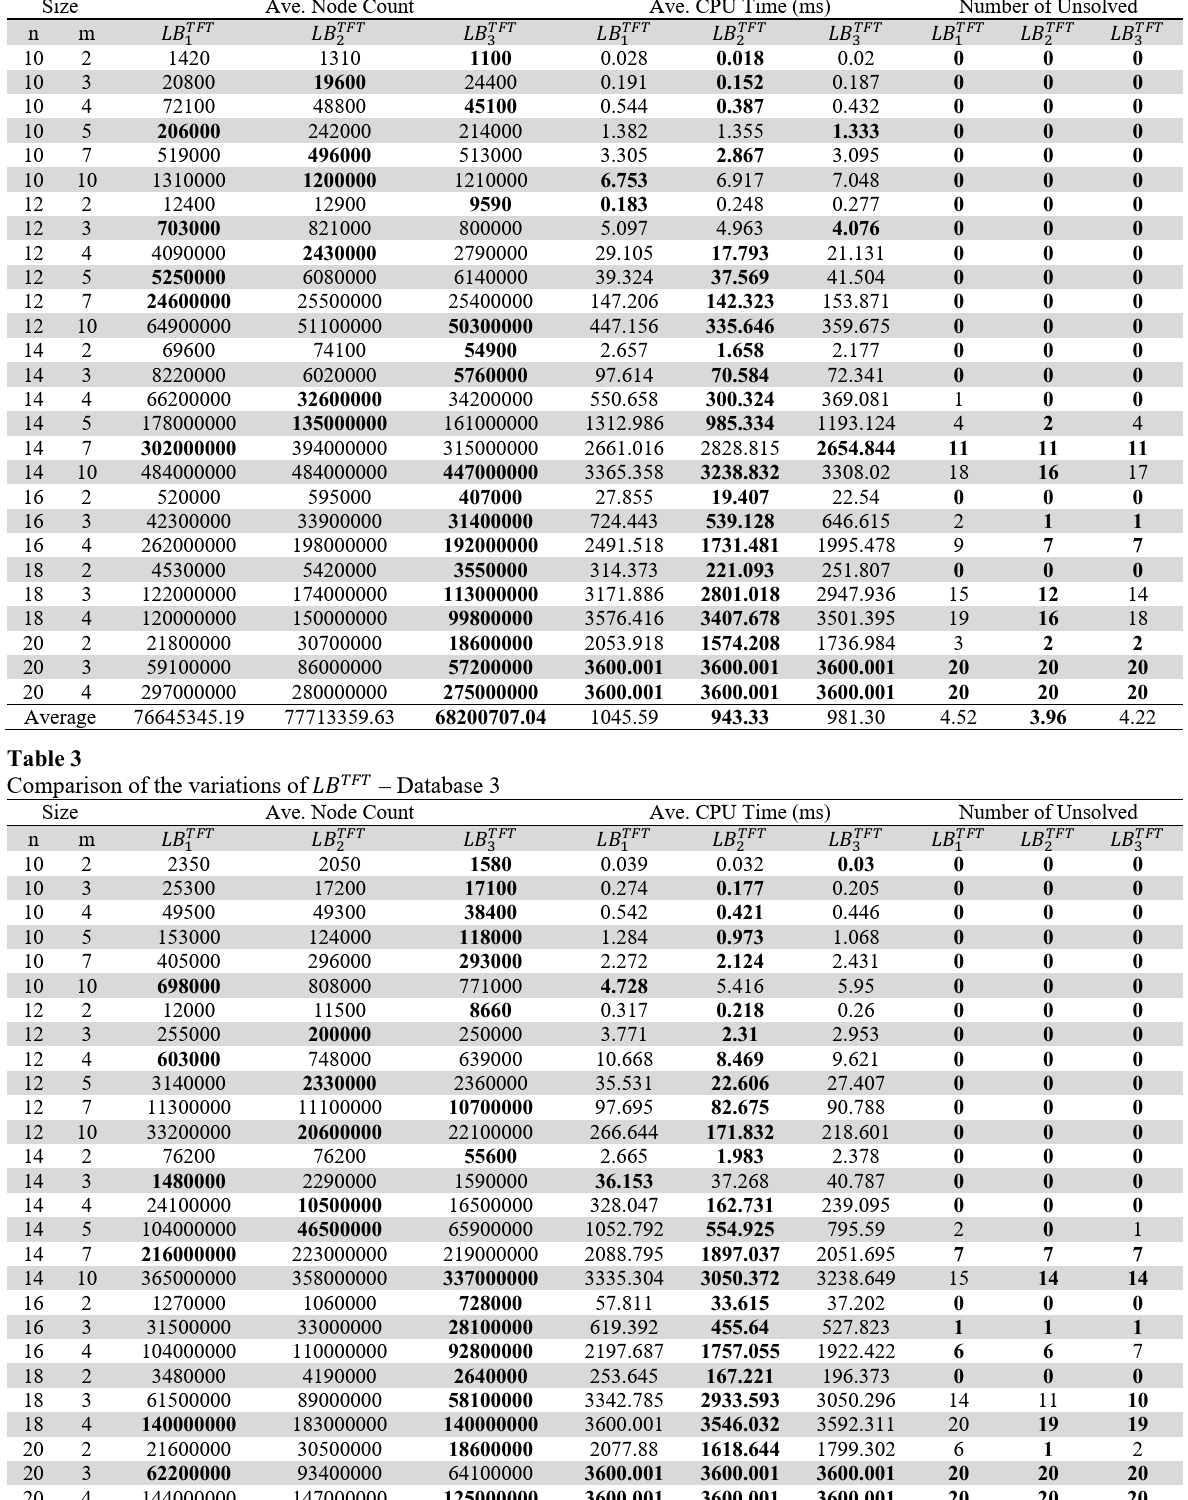
Comparison of the variations of 𝐿𝐵 (cid:3021)(cid:3007)(cid:3021) – Database 2